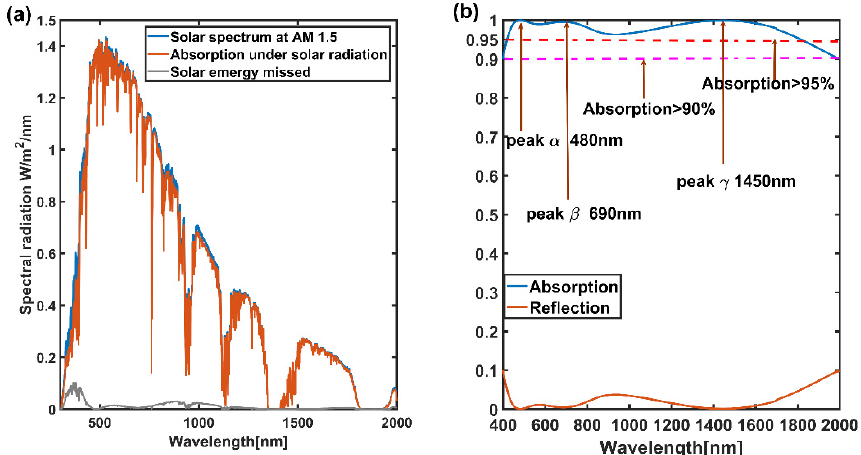
Figure 2. Diagram of optimal absorption efficiency. ( a ) Actual absorption graph of solar energy spectrum; ( b ) Absorption and loss efficiency graph.